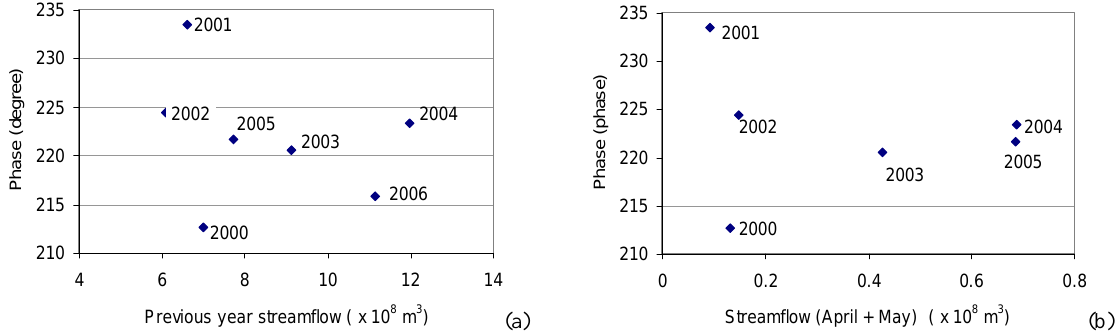
Fig. 10. (a) Area-averaged phase value of 12-month Fourier harmonic component of year N versus total river streamflow of year ( N − 1); (b) area-averaged phase value of 12-month component of year N versus total river streamflow of April through May of year N . The river streamflow was measured at the Zhengyixia gauge station.